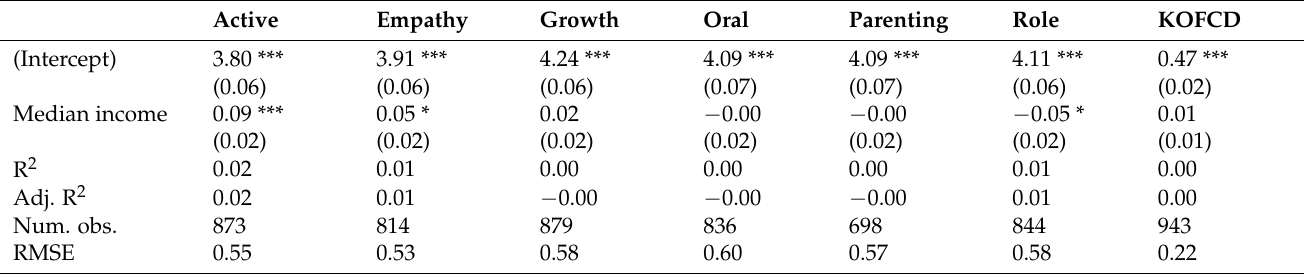
Table 7. Associations between respondents’ zip code’s median income category and APKAS re- sponses by category.